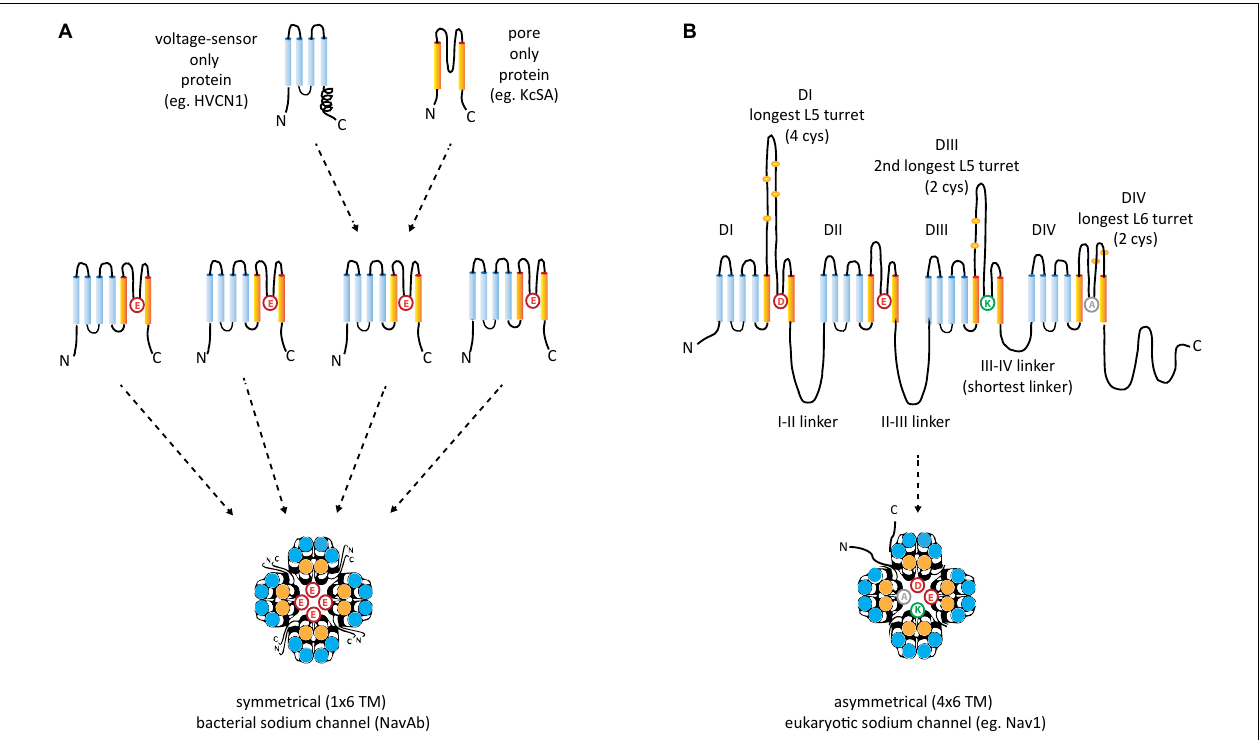
FIGURE 2 | Structural comparisons between (A) symmetrical, 1 × 6 TM (TM = transmembrane) homotetrameric, bacterial Na channels consisting of four repeat subunit (B) asymmetrical, eukaryotic four domain calcium and sodium channels consisting of 24 transmembrane segments (4 × 6 TM). Each of the four sodium and calcium channel domains consist of a voltage-sensor domain of four transmembrane segments, S1–S4 (blue), akin to voltage sensor only protein (e.g., HVCN1) and a pore domain, S5–S6 (orange), resembling the size of the two membrane segments of the inward rectifying K channels (e.g., KcsA). A dramatic difference between the 1 × 6 TM bacterial sodium channels and 4 × 6 TM calcium and sodium channels are the larger sizes of extracellular turrets rising before the pore selectivity filter, especially L5 I and L5 III which range from 40 to 105 amino acids long. The longest extracellular turret in Domain IV in 4 × 6 TM channels is always the extracellular turret rising after the pore selectivity filter (L6 IV ), while L5 IV (the extracellular loop just before the pore selectivity filter) is always short. Comparatively speaking, 1 × 6 TM channels all possess short extracellular turrets of 10–15 amino acids long. Eight core, conserved cysteines populate the L5 I - L5 II - L5 III - L6 IV extracellular turrets in a 4-0-2-2 configuration in all eukaryotic 4 × 6 TM channels. Also novel are singleton N- and C-termini, and cytoplasmic linkers, of which the III-IV linker is almost always 53–57 amino acids long in eukaryotic 4 × 6 TM